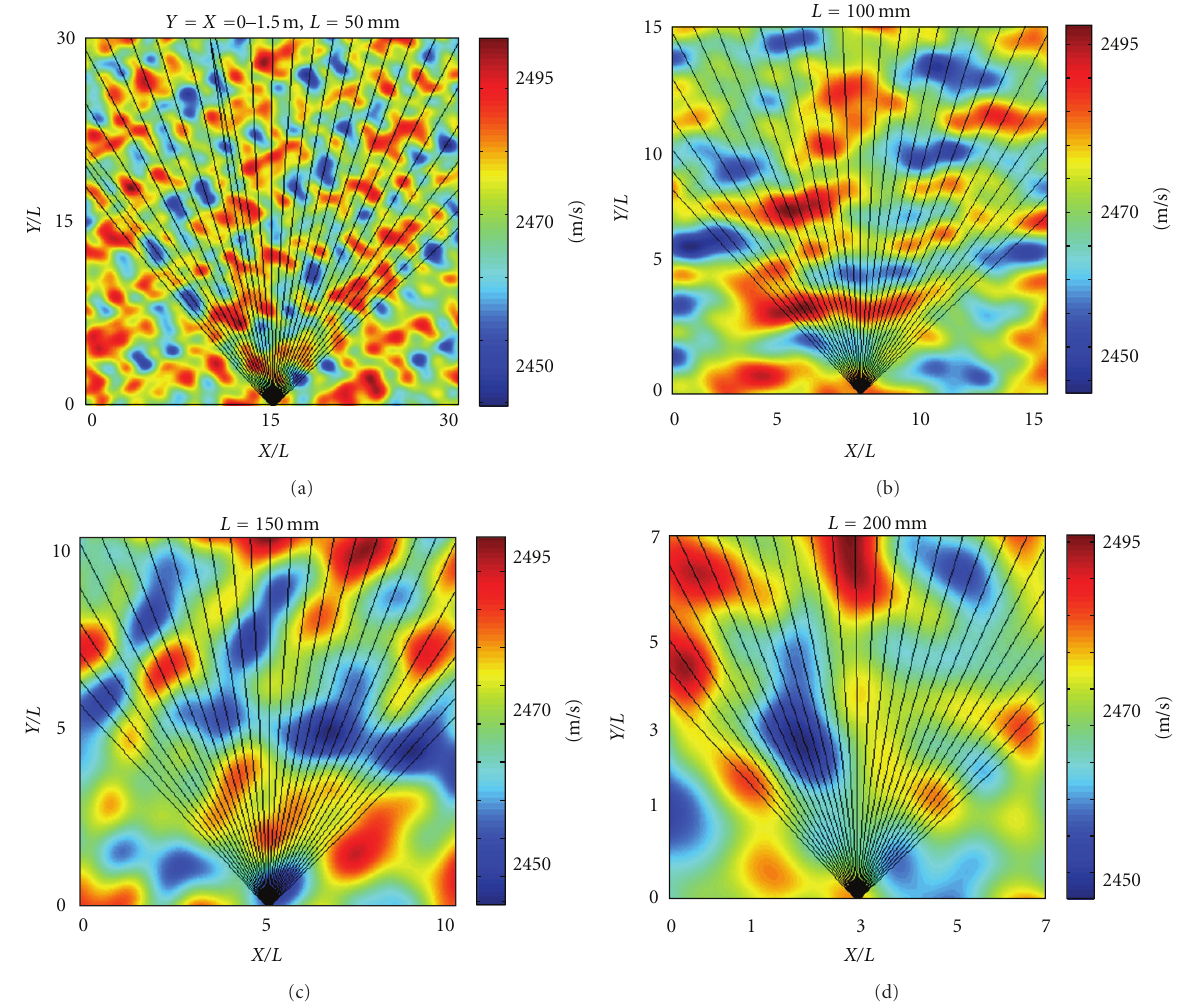
Figure 7: Ray tracing using the determinist model for four di ff erent values of the characteristic length.